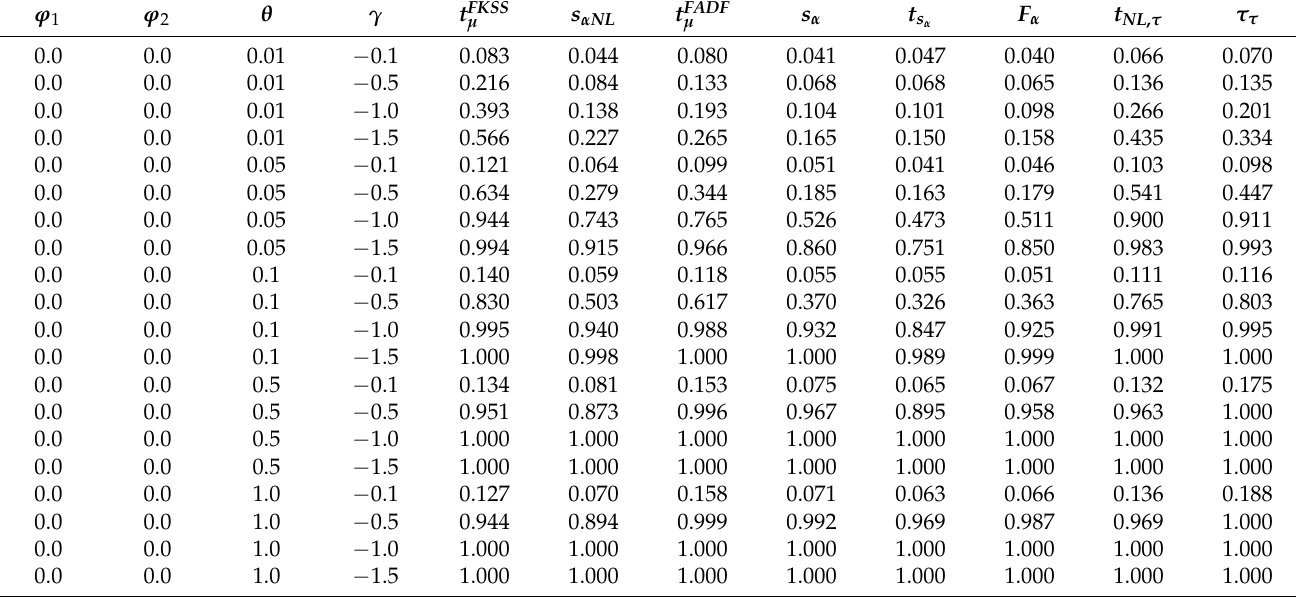
Table 4. The simulated powers of alternative tests under the KSS 1st